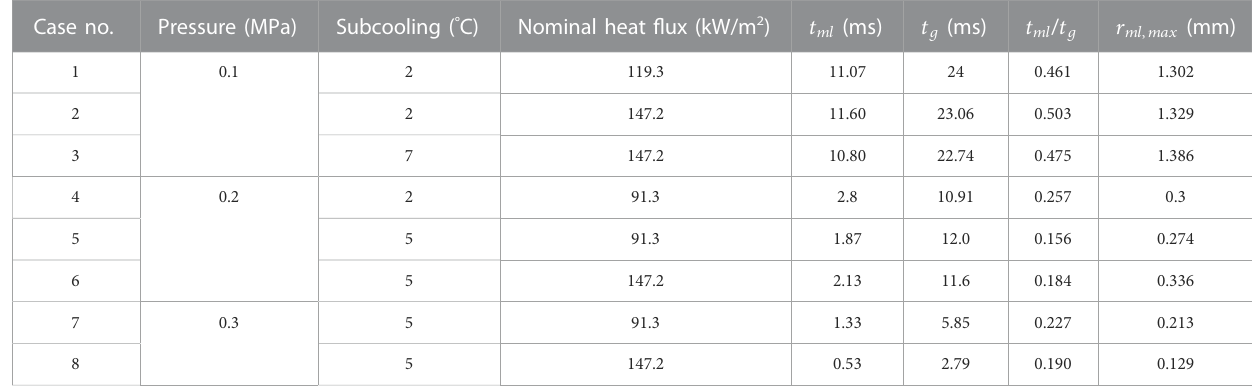
TABLE 1 Parameter con fi guration of the test